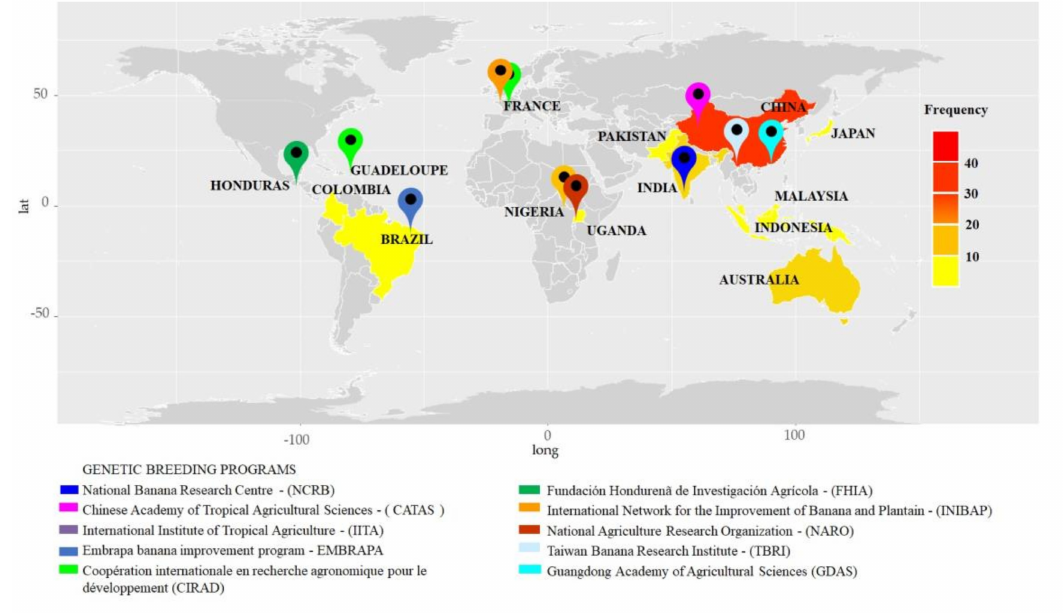
Figure 4. Frequency of articles on genetic improvement of Musa spp. to Fusarium wilt published in the last ten years in different countries and genetic breeding programs of the banana mentioned. The light yellow tones indicate a frequency below 10% of the articles considered in this review; the intermediate tones indicate frequencies between 10 and 30%, and the intense red tones indicate frequencies above 40%. The location icons indicate the locations of Musa breeding programs identified by the colors. The map was plotted in R, using the packages maps, ggmap, geosphere, Eurostat, GADMTools, country code and ggplot2. lat: latitude; long: